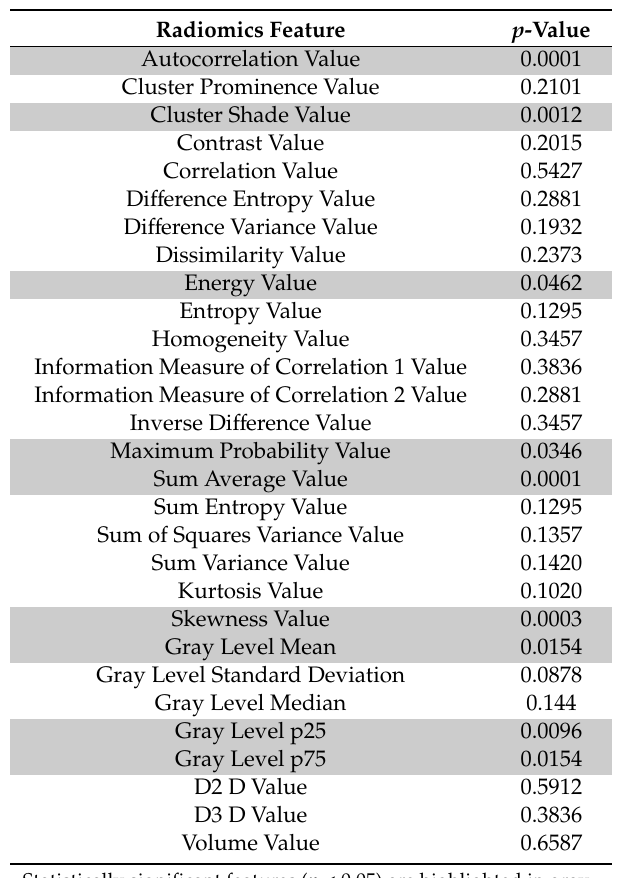
Table 3. Values of MR radiomics features of pleomorphic adenoma versus malignant